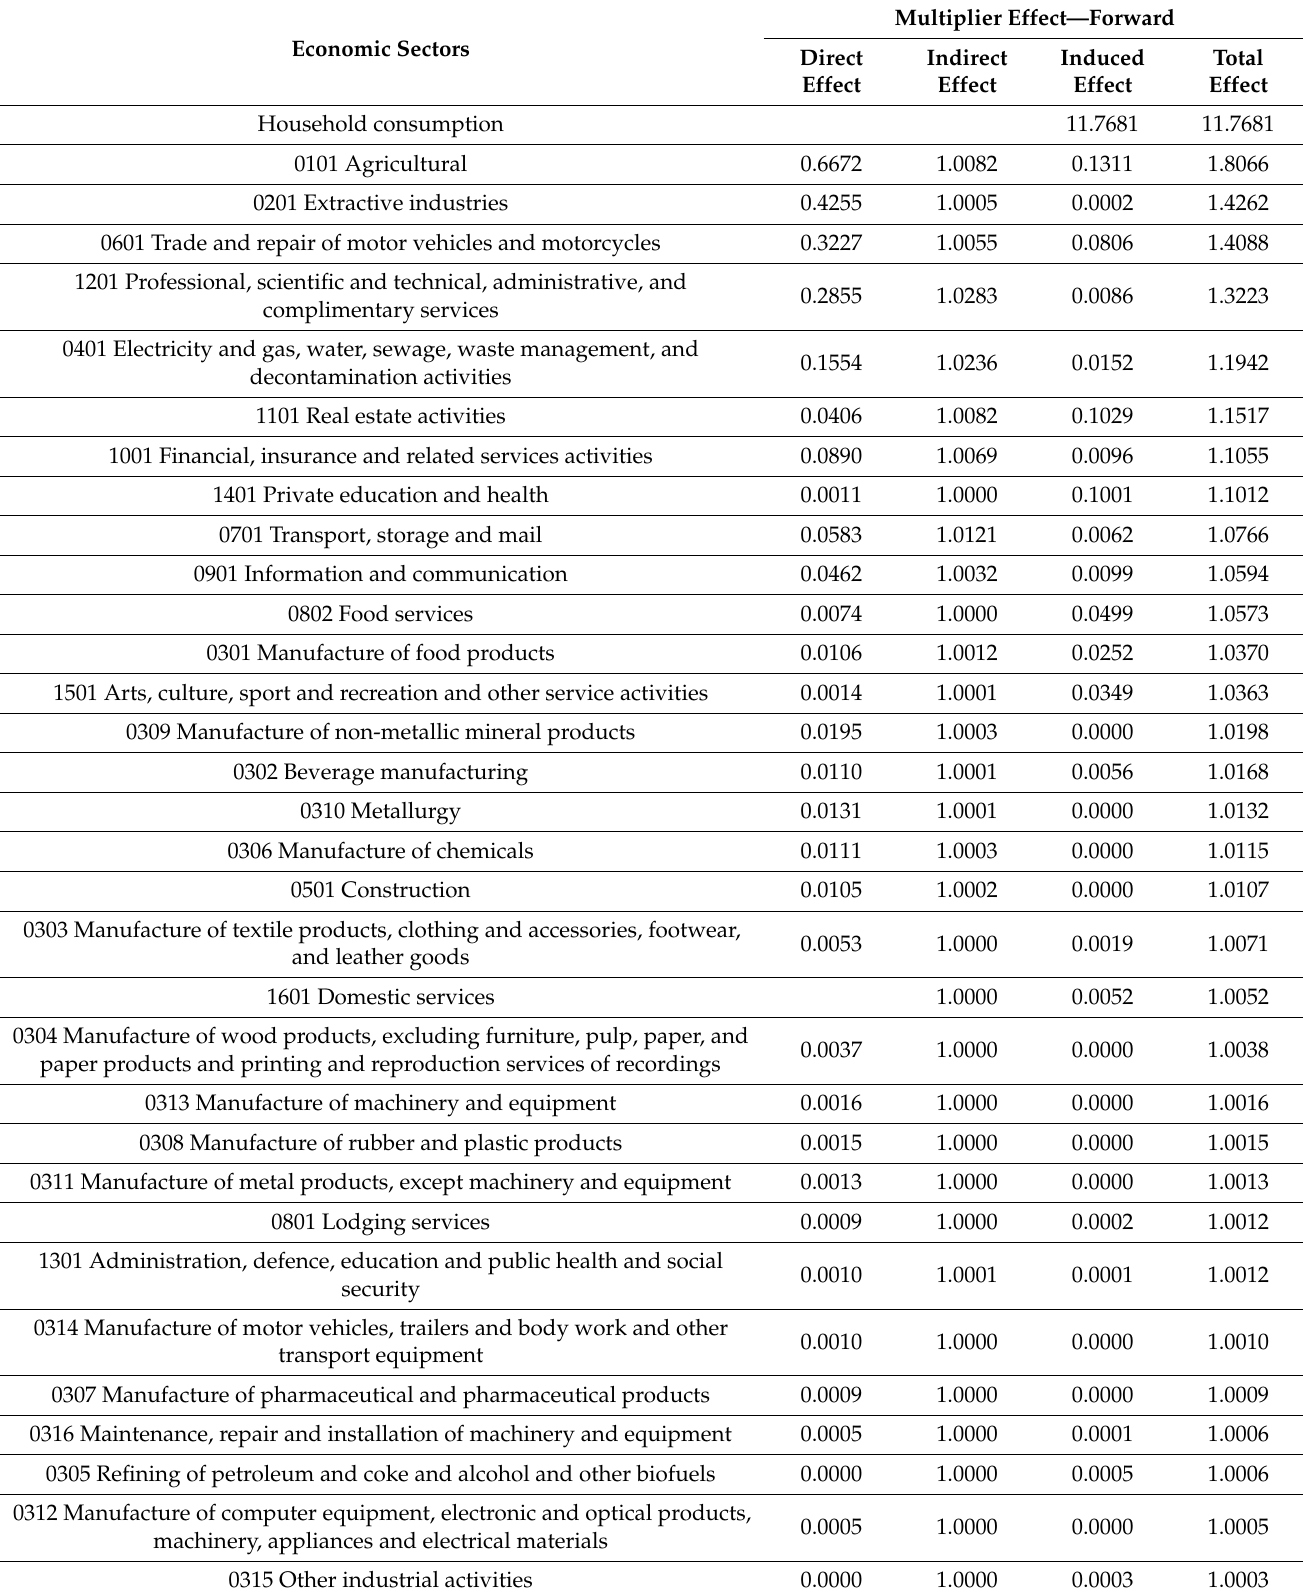
Table A4. Economic sectors with greater impact multiplier effect—Forward (Direct, indirect and induced, and total effects) on water flows, Cear á